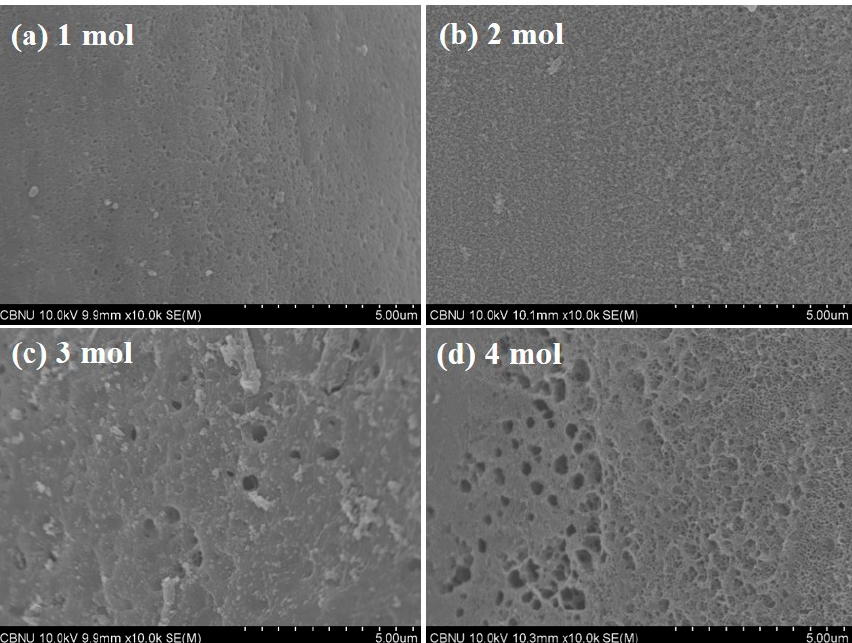
Figure 10. SEM images of the carbonized and activated LDPE/HDPE sheath-core fibers at various KOH molarity: ( a ) 1 mol; ( b ) 2 mol; ( c ) 3 mol; ( d ) 4 mol.